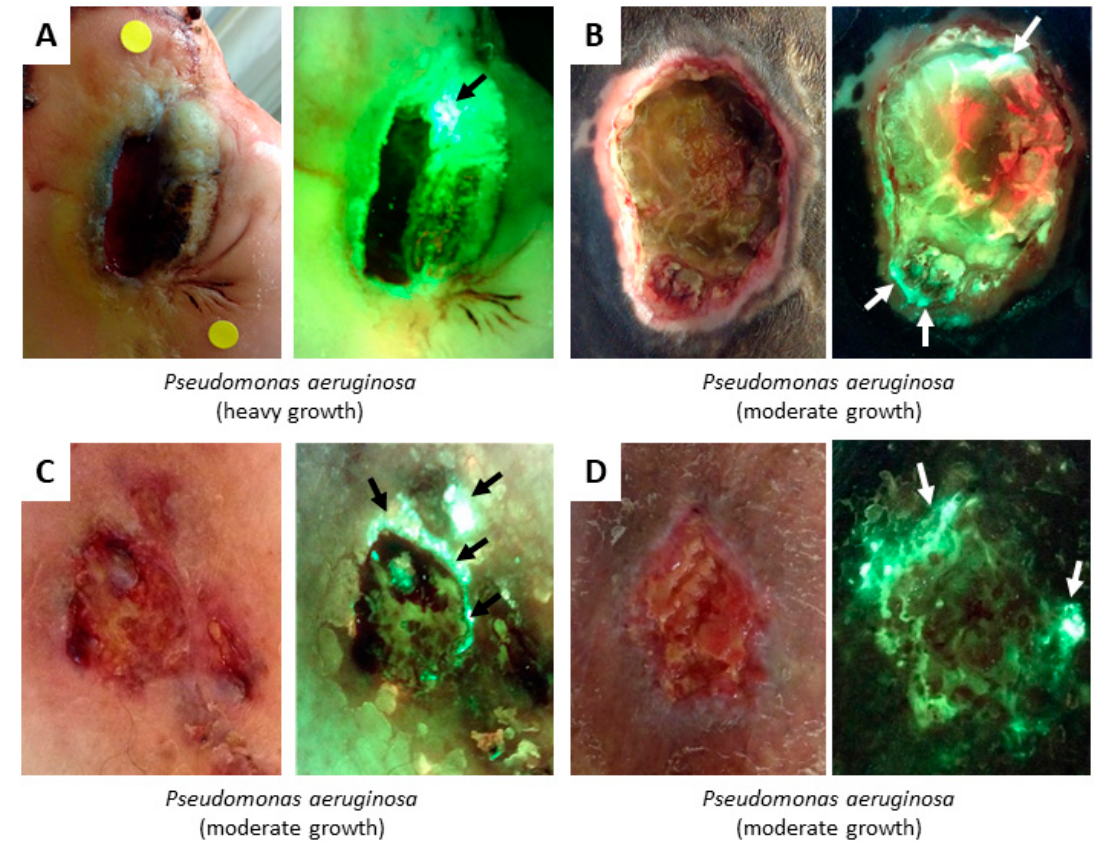
Figure 6. Cyan and glowing white fluorescence from P. aeruginosa. Endogenous pyoverdines found in P. aeruginosa emit cyan fluorescence when excited by 405 nm violet light. ( A – D ) All wounds show a standard image on left and fluorescence image on right, with arrows denoting regions of cyan fluorescence. The cyan signal can oversaturate the camera, resulting in a glowing white region, as seen in wounds A (black arrow), B (top arrow), and C . Wounds were sampled in regions of cyan or white fluorescence using a swab; microbiological cultures confirmed the presence of P. aeruginosa in all cases. Wound A —DFU; Wound B —Pressure ulcer (also demonstrates red fluorescence, but the region of red was not sampled); Wounds C and D —VLUs.